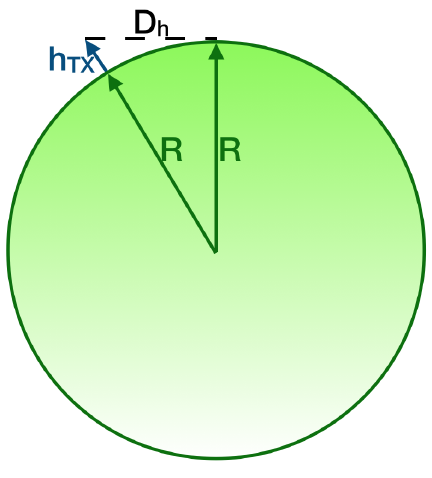
Figure 3. Evaluation of the distance from the horizon.